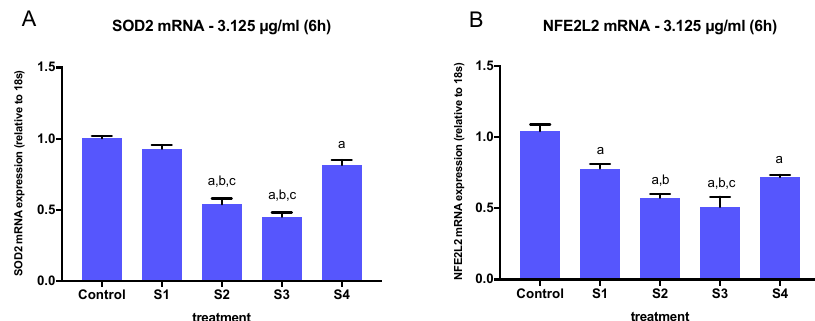
Figure 8. Expression of oxidative stress genes (relative to 18S expression) in BEAS-2B cells treated with S1–S4 soot at 3.125 ug / mL for 6 h. ( A ) Superoxide dismutase 2 (SOD2) mRNA. ( B ) Nuclear factor erythroid 2-related factor 2 (NFE2L2) mRNA. The graphs summarize data from three independent replicates, with gene expression results normalized to controls (exposed to DMSO) and expressed as mean ± SEM. a: different from control, b: different from S1, c: different from S4. One-way ANOVA ( p < 0.05). Biomedicines 2020 , 8 , x FOR PEER REVIEW